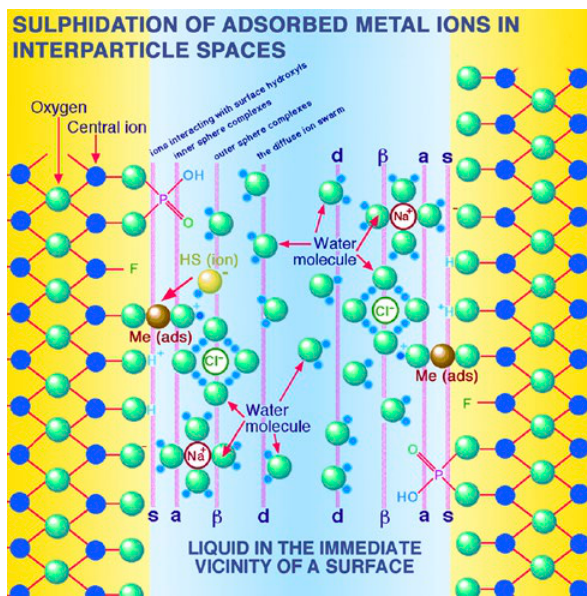
Figure 73. Metal sulphides are formed “molecule by molecule” as soon as buried sediments encounter hydrogen sulphide generated by the bacterial reduction of sulphates. In tidal flats and mangrove swamps reducing conditions (sulphidic) occur a few centimetres below the sediment-water interface but basin sediments generally are anoxic from a few meters below the sea floor.